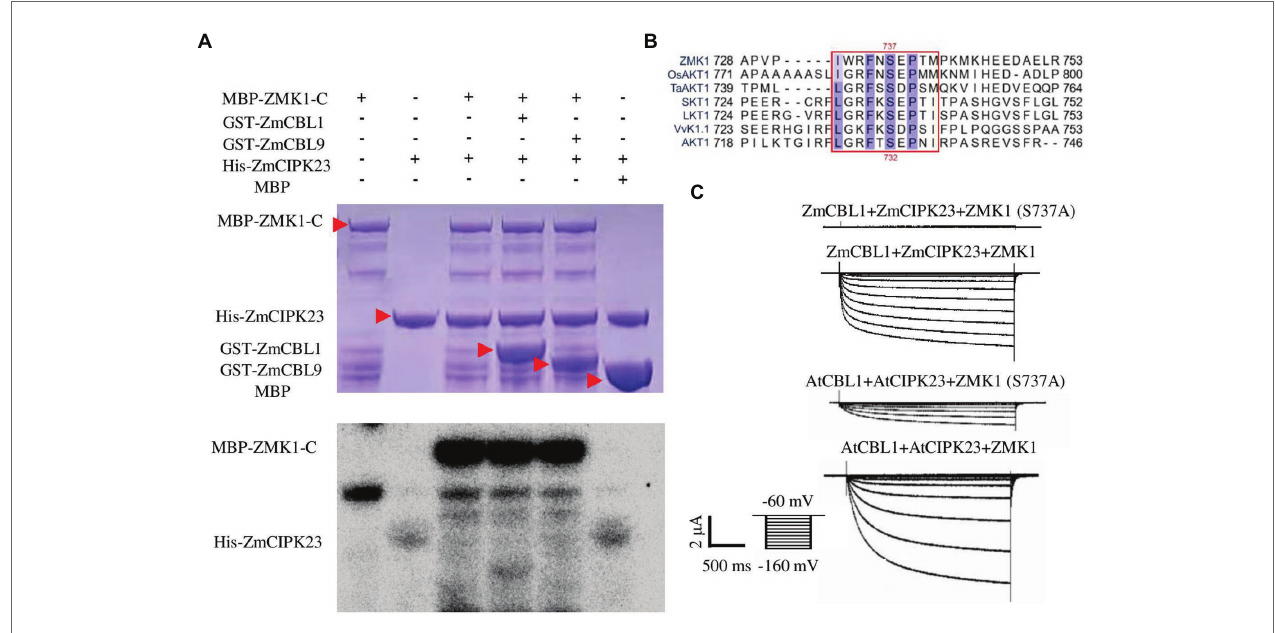
FIGURE 5 | ZmCIPK23 can phosphorylate ZMK1. (A) In vitro phosphorylation of ZMK1 by ZmCIPK23. ZMK1-C is the cytosolic region of ZMK1 fused with MBP. (B) Serine 737 is essential for ZMK1 activation. Sequences were aligned Clustal X software. The amino acids conserved in all species were highlighted, underlining the sequences that fit the conserved phosphorylation motif of CBL-interacting protein kinases (CIPKs). (C) From top to bottom, representative currents traces in oocytes expressing ZmCBL1+ZmCIPK23+ZMK1(S737A), ZmCBL1+ZmCIPK23+ZMK1, AtCBL1+AtCIPK23+ZMK1 (S737A), and AtCBL1+AtCIPK23+ZMK1. Values were means ± SE ( n = 5